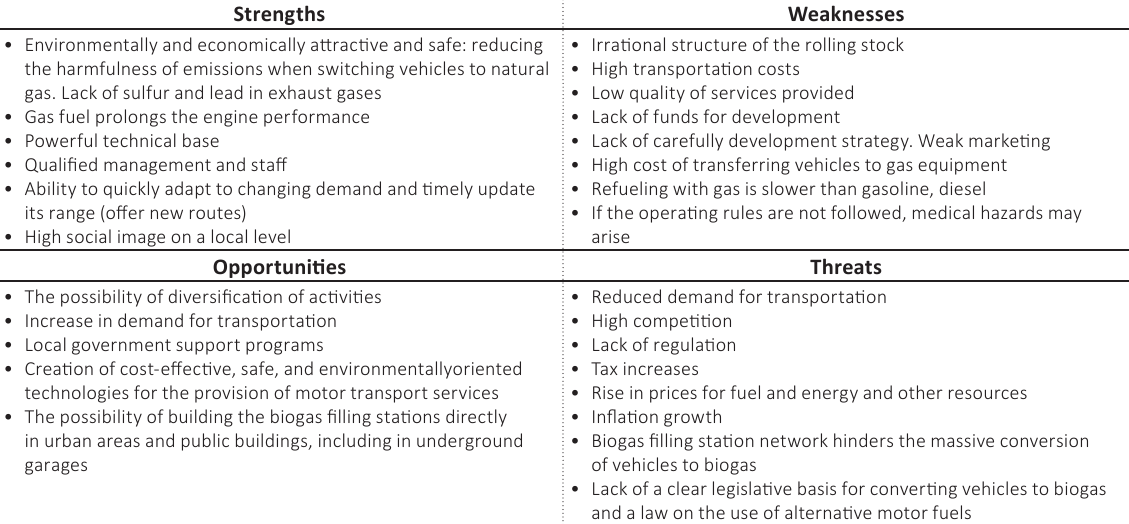
Table 4. SWOT analysis of a transport company implementing a greening strategy by switching to biogas